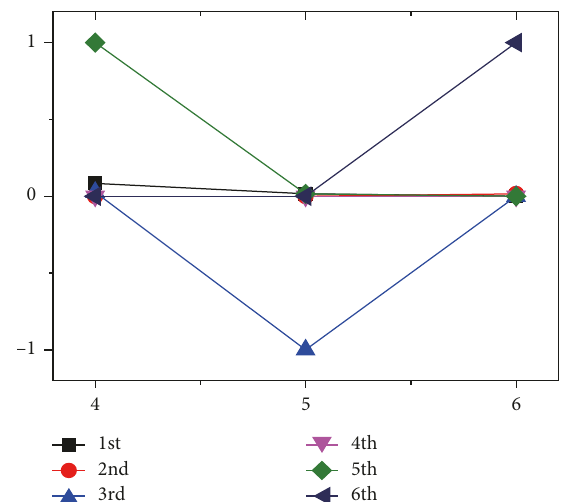
Figure 4: Torsional vibration mode of 1–6 orders. 4: ψ degree of freedom; 5: ψ y direction degree of freedom; 6: ψ z direction degree of freedom.